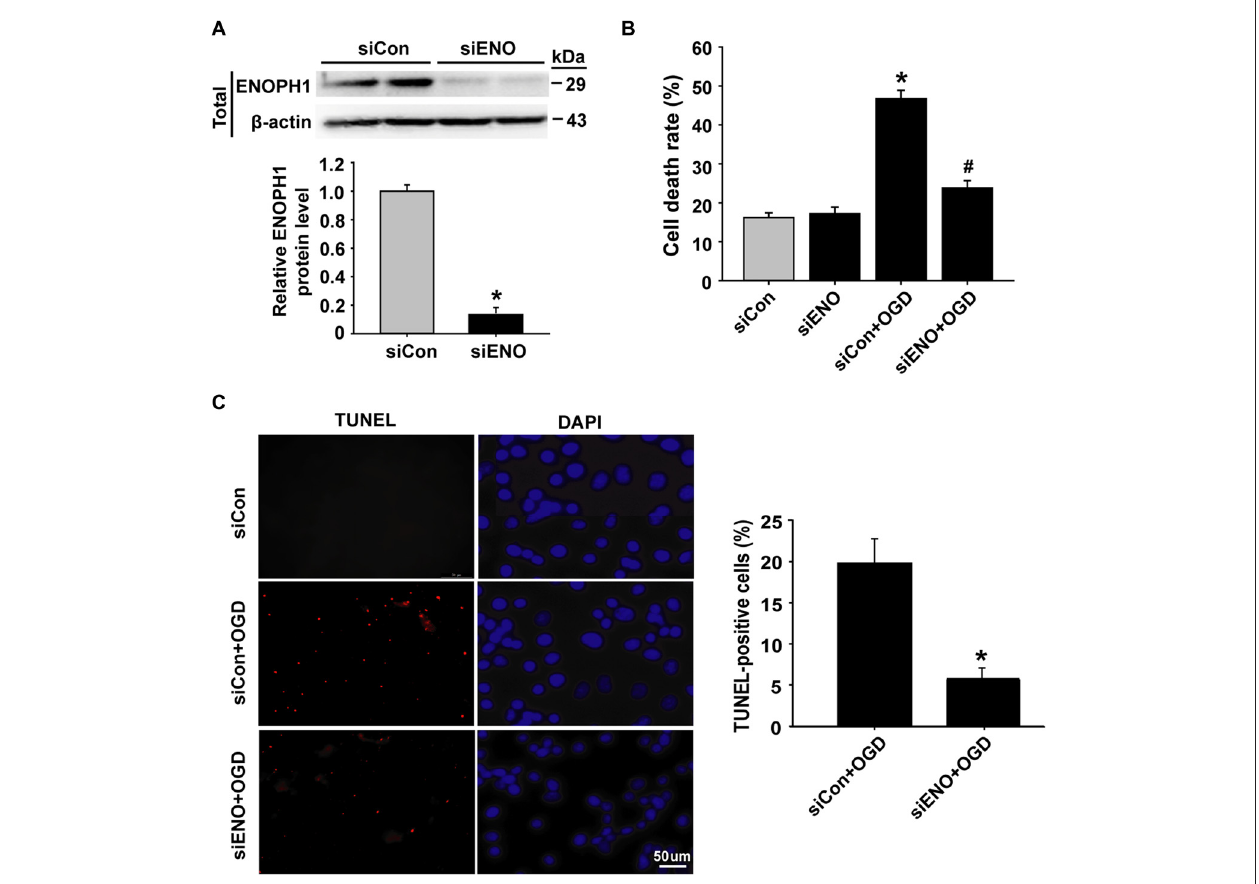
FIGURE 3 | Knockdown of ENOPH1 attenuates OGD-induced apoptosis in bEND3 cells. (A) ENOPH1 siRNA effectively knocked down ENOPH1 protein expression in bEND3 cells. Western blot analysis showed that incubation bEND3 cells with ENOPH1 siRNA (siENO) for 48 h significantly ( ∼ 90%) reduced ENOPH1 protein levels. Upper panel: representative immunoblots of ENOPH1 and the loading control β -actin; bottom panel: quantitative data of protein band intensity after normalization to β -actin. ∗ P < 0.05 vs. Control siRNA (siCon); n = 4. (B) Knockdown of ENOPH1 significantly reduced 6 h OGD-induced cell death assessed by LDH release. ∗ P < 0.05 vs. siCon; # P < 0.05 vs. siCon + OGD; n = 4. (C) TUNEL assay showed that 6 h OGD significantly increased the number of TUNEL-positive apoptotic endothelial nuclei (red fluorescence) and knockdown of ENOPH1 significantly decreased this increase. Left panel: representative micrographs of double staining of TUNEL and DAPI (blue, counter staining), bar = 50 µ m; right panel: quantitative data of TUNEL-positive cells. ∗ P < 0.05 vs. siCon + OGD; Experiments were repeated four times ( n =